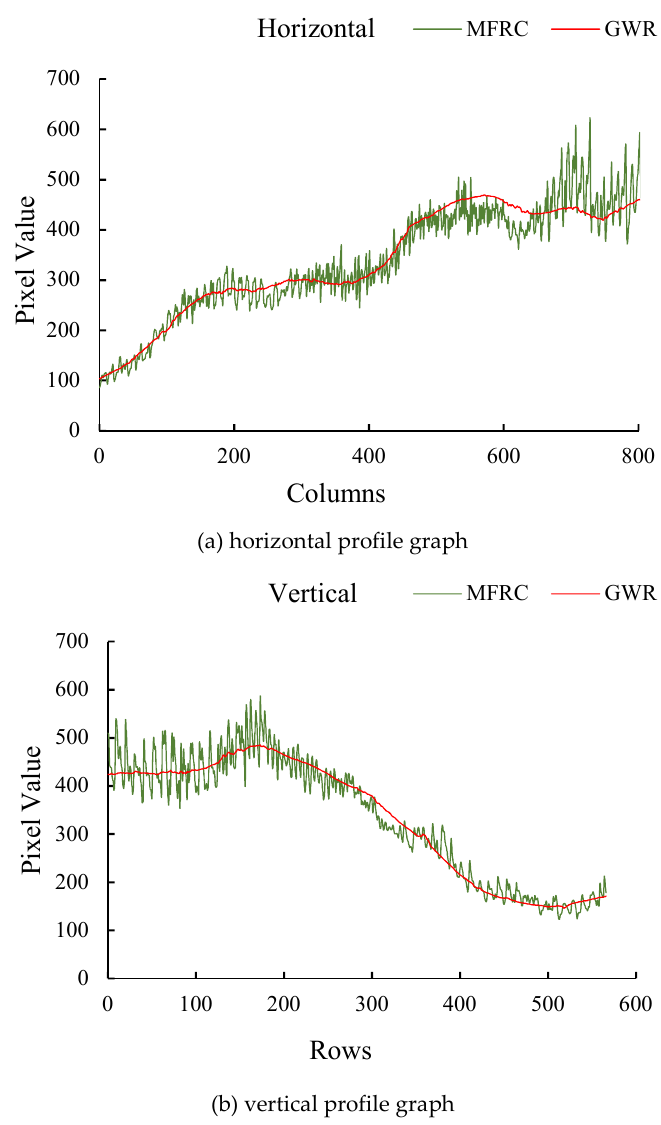
Figure 14. The horizontal profile graph ( a ) and vertical profile graph ( b ) of GWR and MFRC downscaled results at the Wuhan rain gauge station in July 2016.